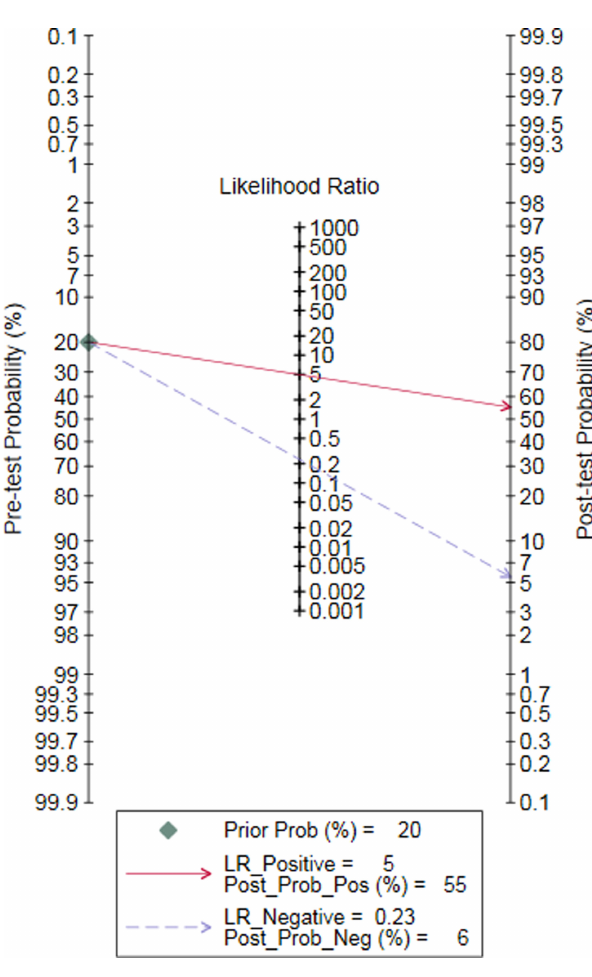
Figure 5. Fagan’s nomogram of procalcitonin in the diagnosis of SAP. SAP, severe acute